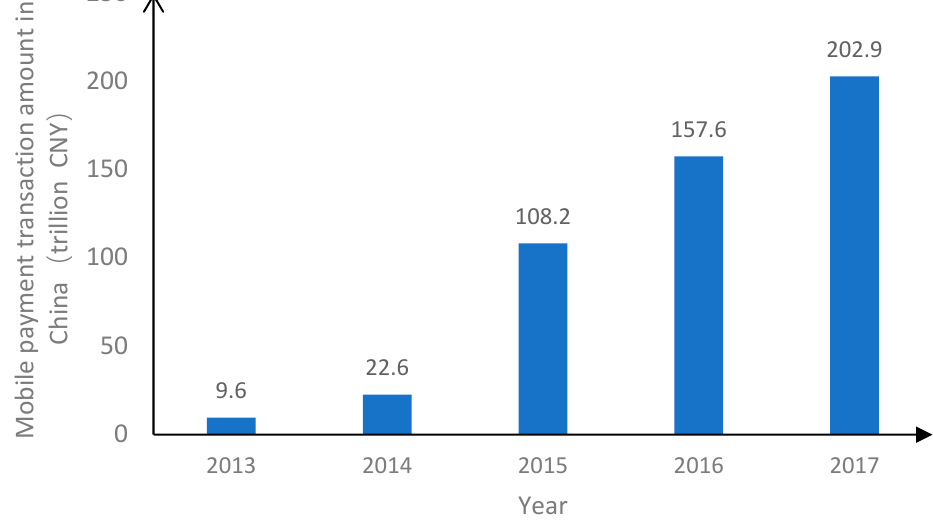
Figure 1. The market transaction volume of China mobile payment (Data source: The People’s Bank of China).